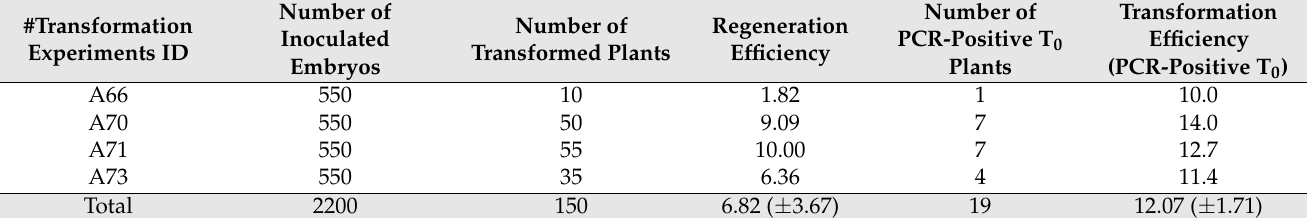
Table 1. Cotton plant regeneration and transformation efficiency data from eight independent cotton embryo axis transformation experiments. Transformation efficiency was calculated based on the number of PCR-positive plants divided by the number of transformed plants, which were selected by herbicide